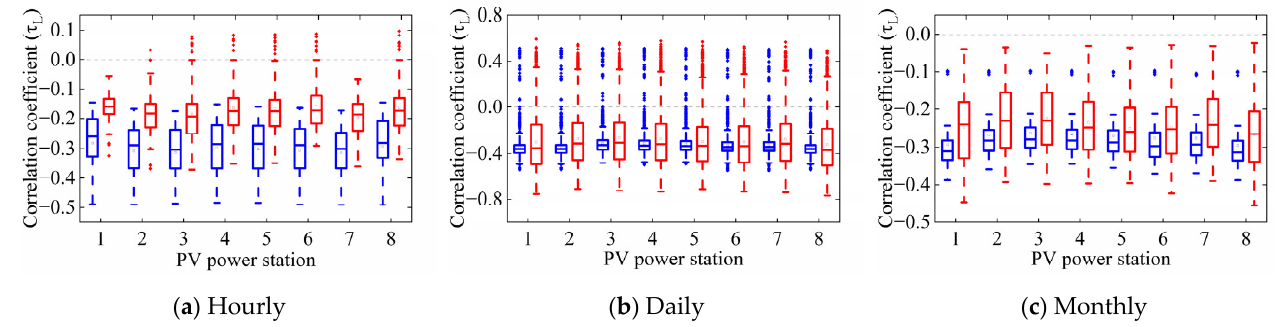
Figure 8. The second type of complementary indicator under different time scales (the blue box represents the solar-solar mode, and the red box illustrates the solar-wind mode).